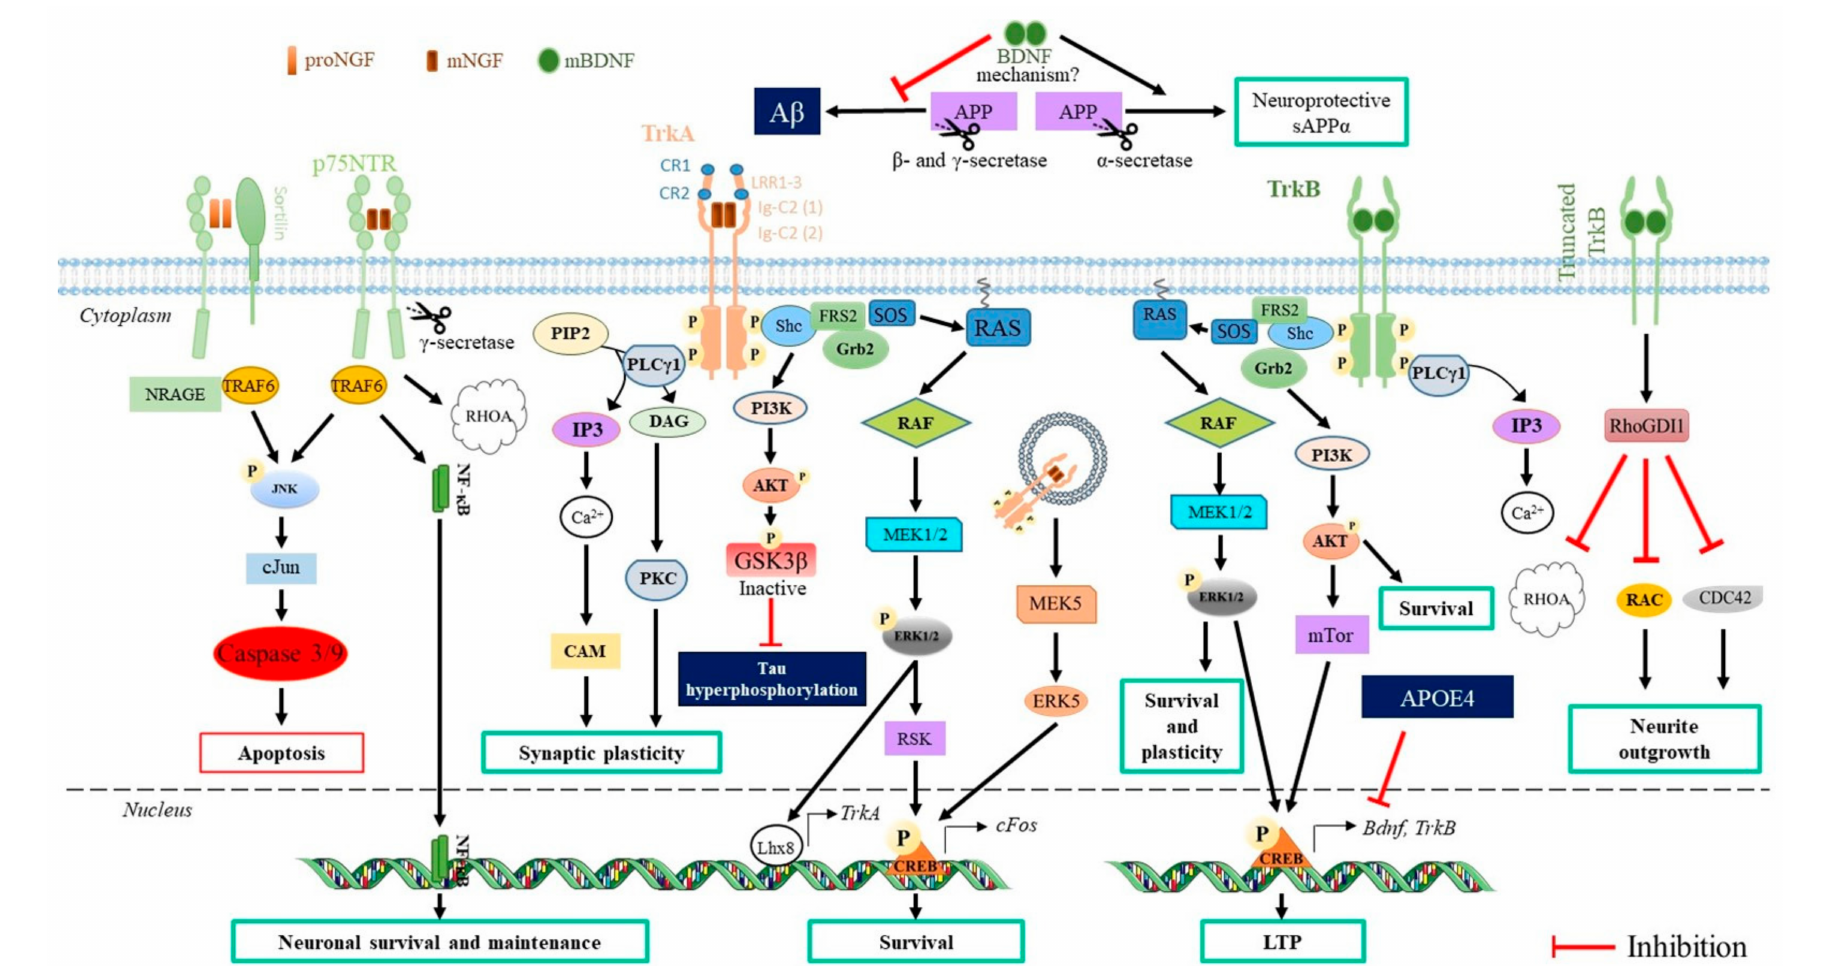
Figure 2. The NGF and BDNF signaling pathways and their roles in healthy and AD brains [70–75]. CAM: calmodulin kinase; DAG: diacylglycerol; mBDNF: mature form of BDNF (monomer); mNGF: mature form of NGF (monomer); RSK: ribosomal S6 kinase; TRAF: TNFR-associated factors. The figure was created using Servier Medical Art (https://smart.servier.com; 30 April